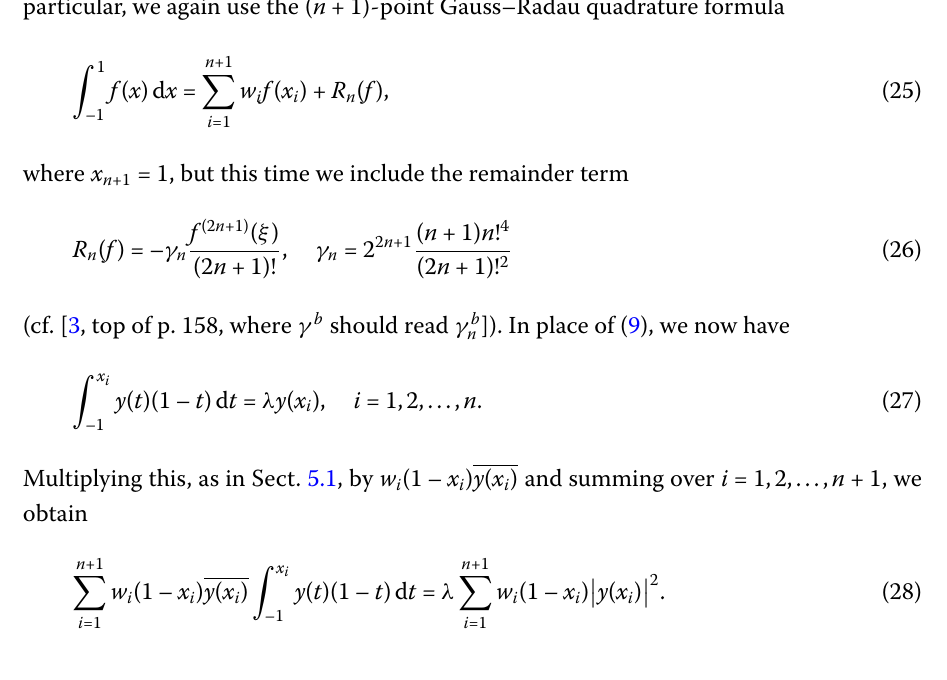
Figure 4 Eigenvalues of the matrix U n for the Laguerre weight function and n = 10,20,40 (from left to